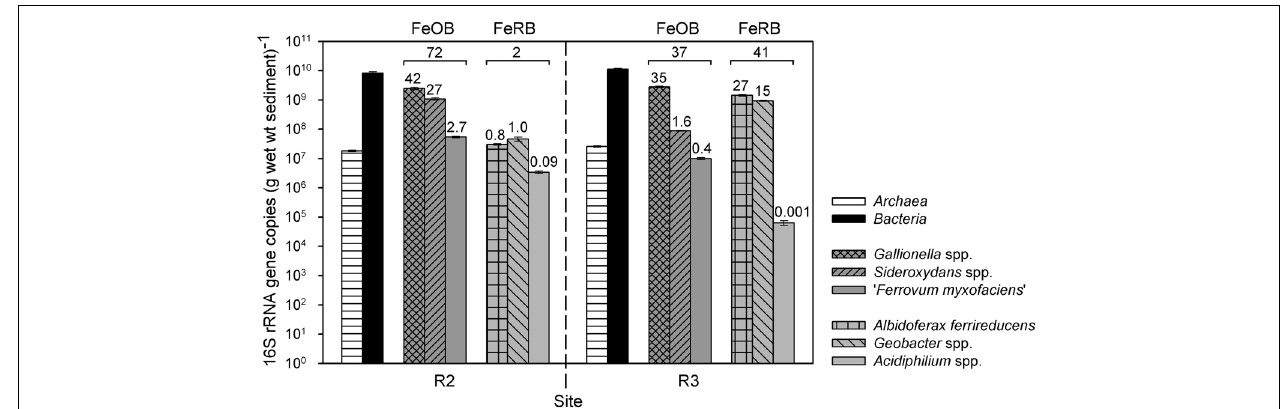
FIGURE 4 | 16S rRNA gene copy numbers of different organism-groups per g wet wt sediment of sites R2 (pH 4.4) and R3 (pH 6.3). Given are means and standard deviations of triplicate qPCR measurements with group-specific primers. The numbers above the bars represent the % of bacterial communities of a certain FeOB ( Gallionella spp., Sideroxydans spp.,